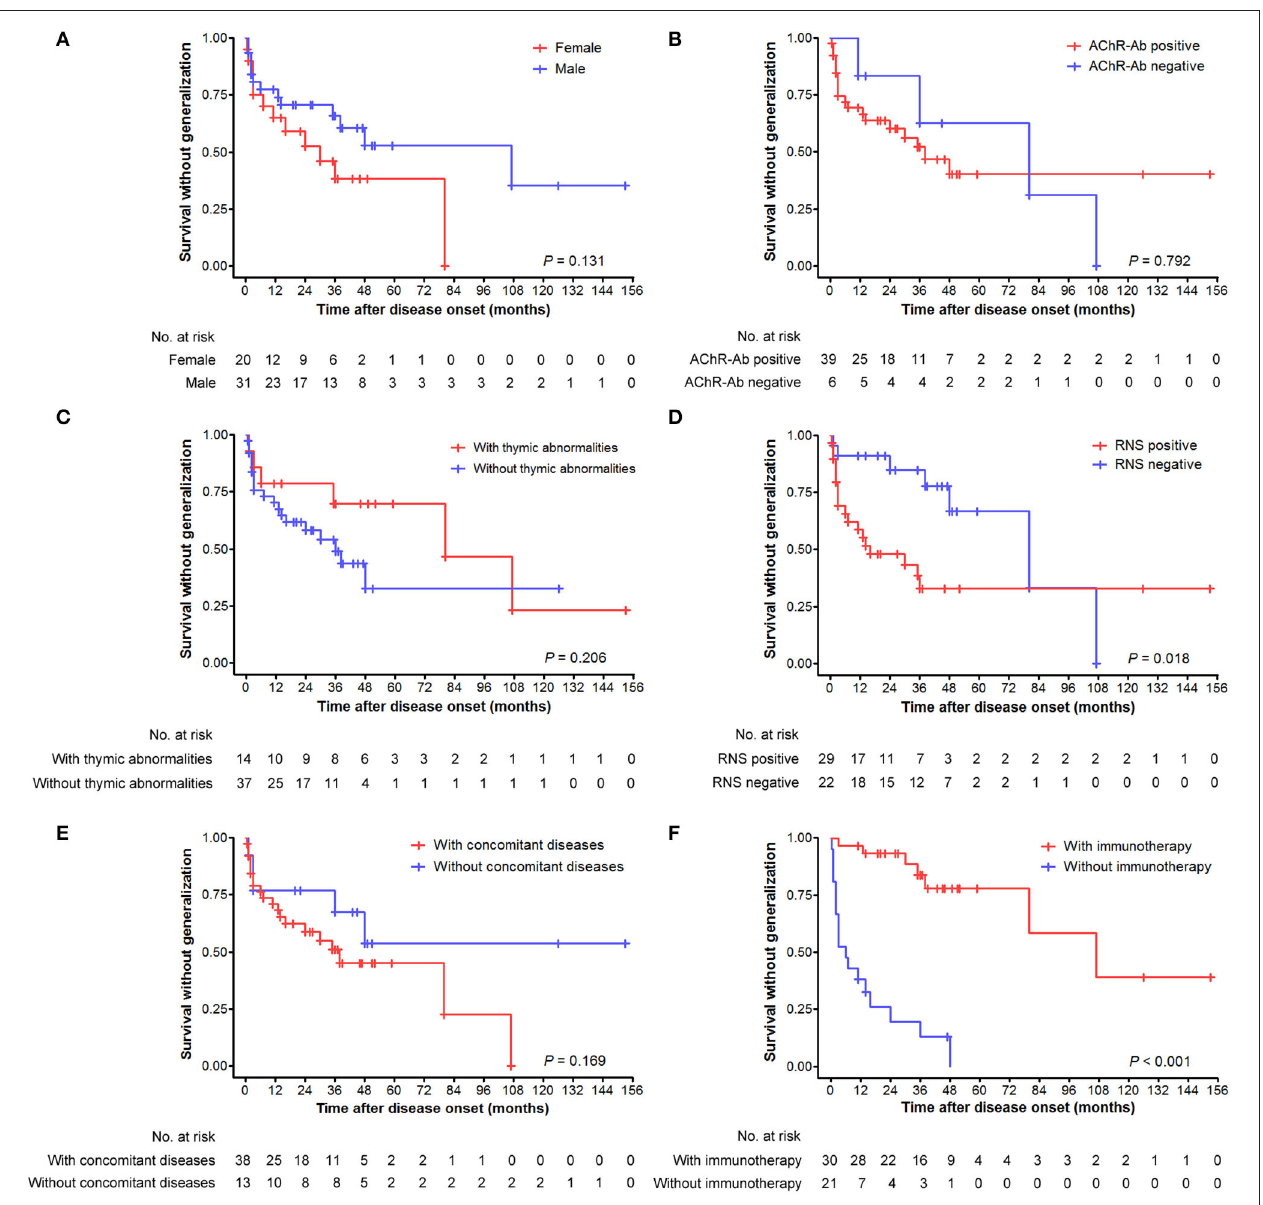
FIGURE 3 | Cumulative survivals without generalization over time (months) as depicted by the Kaplan–Meier curve. (A) Comparison between male and female patients. (B) Comparison between patients with positive and negative AChR antibody. (C) Comparison between patients with and without thymic abnormalities. (D) Comparison between patients with positive and negative RNS test results. (E) Comparison between patients with and without concomitant diseases. (F) Comparison between patients with and without immunotherapy before